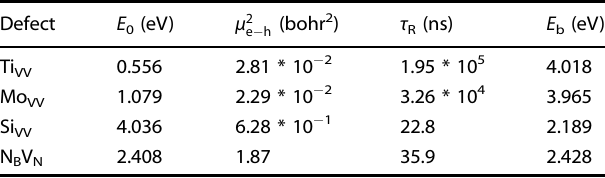
Table 1. Optical excitation energy ( E 0 ), modulus square of the transition dipole moment ( μ 2 ), radiative lifetime ( τ R ) and exciton e (cid:1) h binding energy ( E b ) of several defects in h -BN at the level of theory of G 0 W 0 + BSE @ PBE0( α ).